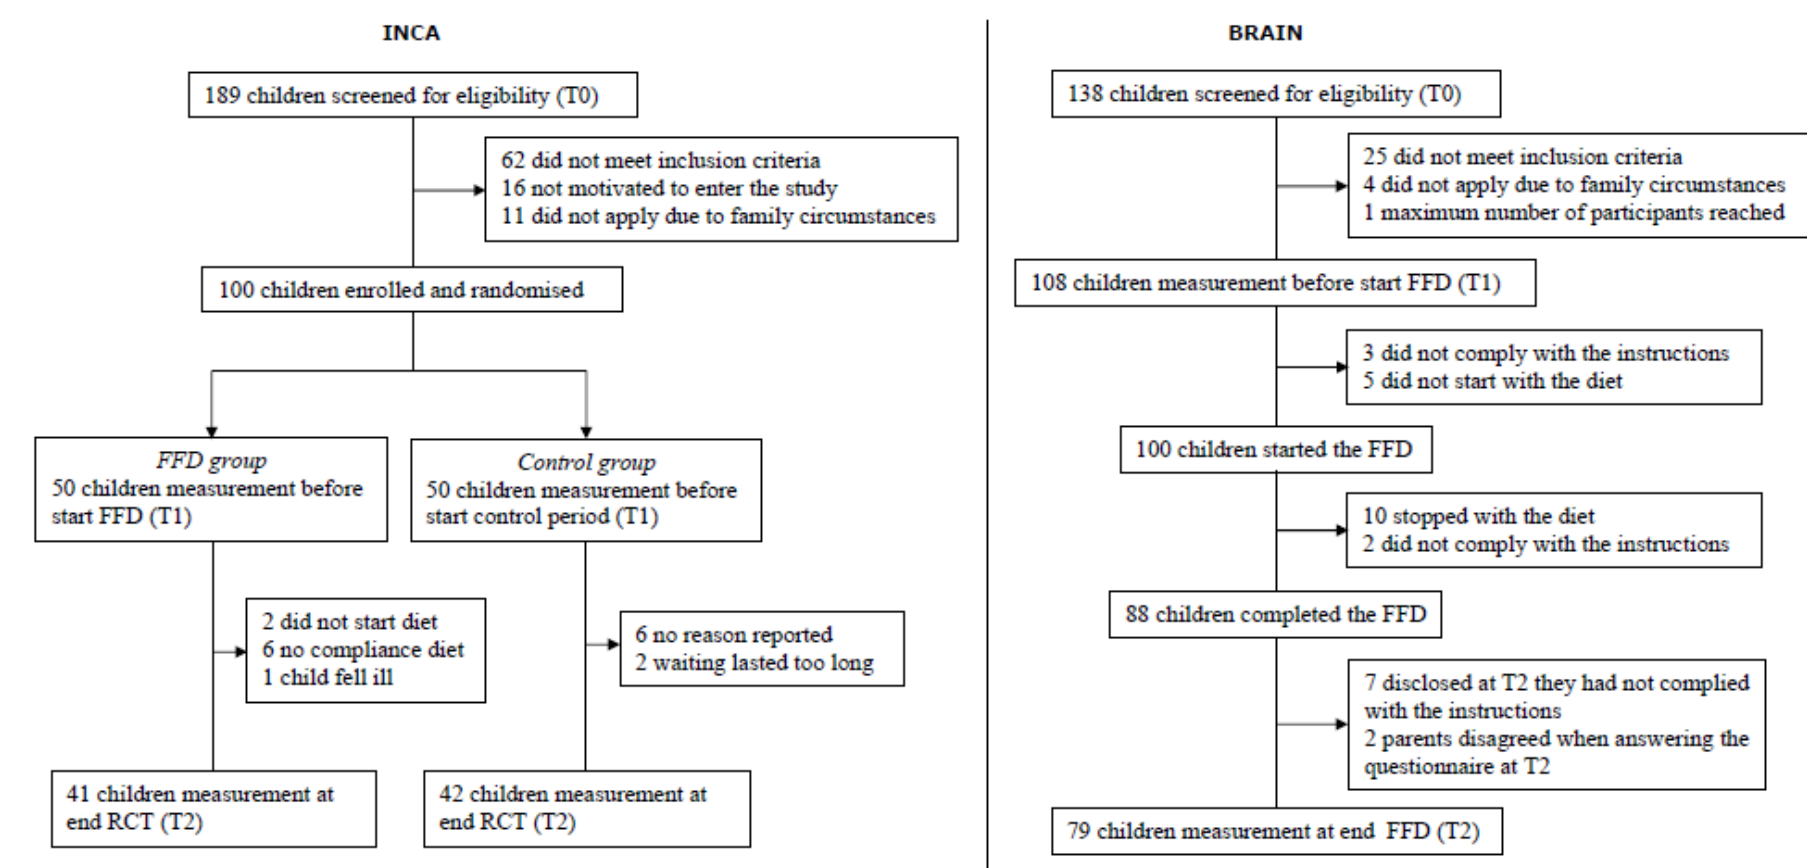
Figure 2. Flow charts for the INCA study and BRAIN study. INCA = Impact of Nutrition on Children with ADHD (randomised controlled trial); BRAIN = Biomarker Research in ADHD: the Impact of Nutrition (open-label trial); FFD = few-foods diet.